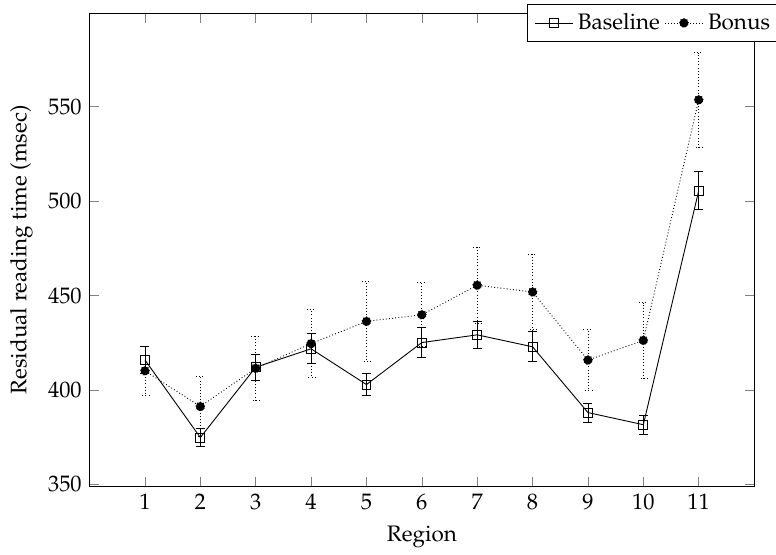
Figure 4. Mean residual reading times for all sentence